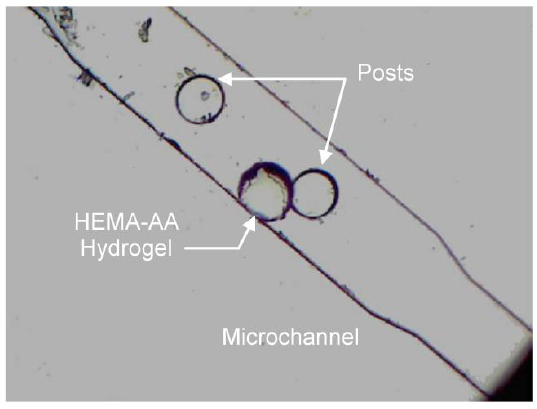
Figure 10. Photograph of the HEMA-AA gel actuator in the microchannel with an ionic solution that has a pH equivalent to reservoir R1.